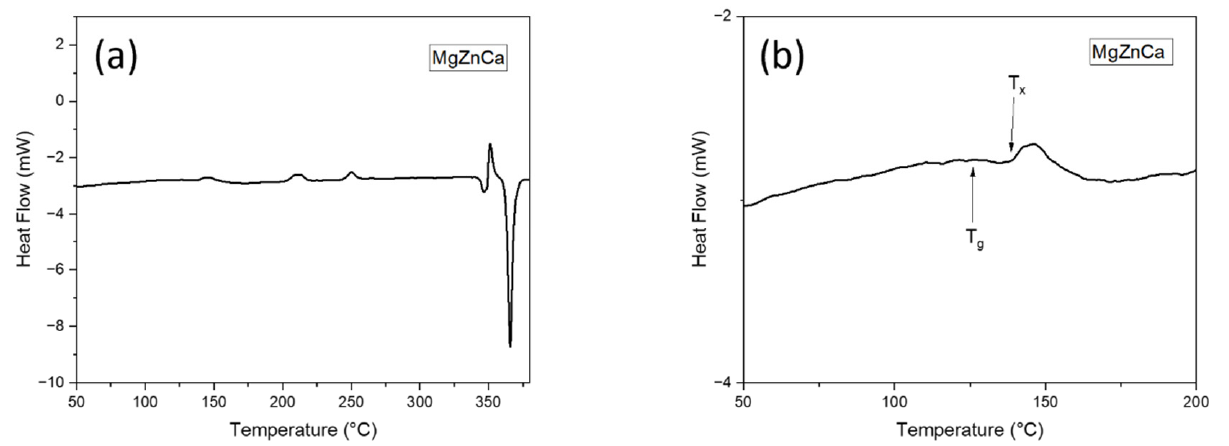
Figure 2. DSC curves of the SPS-ed Mg-Zn-Ca Melt Spun ribbons: ( a ) 50–400 °C and ( b ) 50–200 °C showing both the glass transition temperature (T g ) and crystallization temperature (T x ).